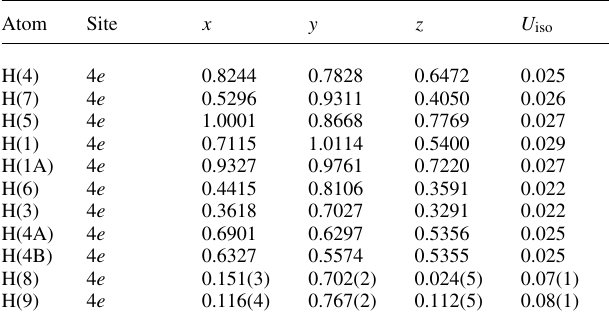
Table 2. Atomic coordinates and displacement parameters (in Å 2 )